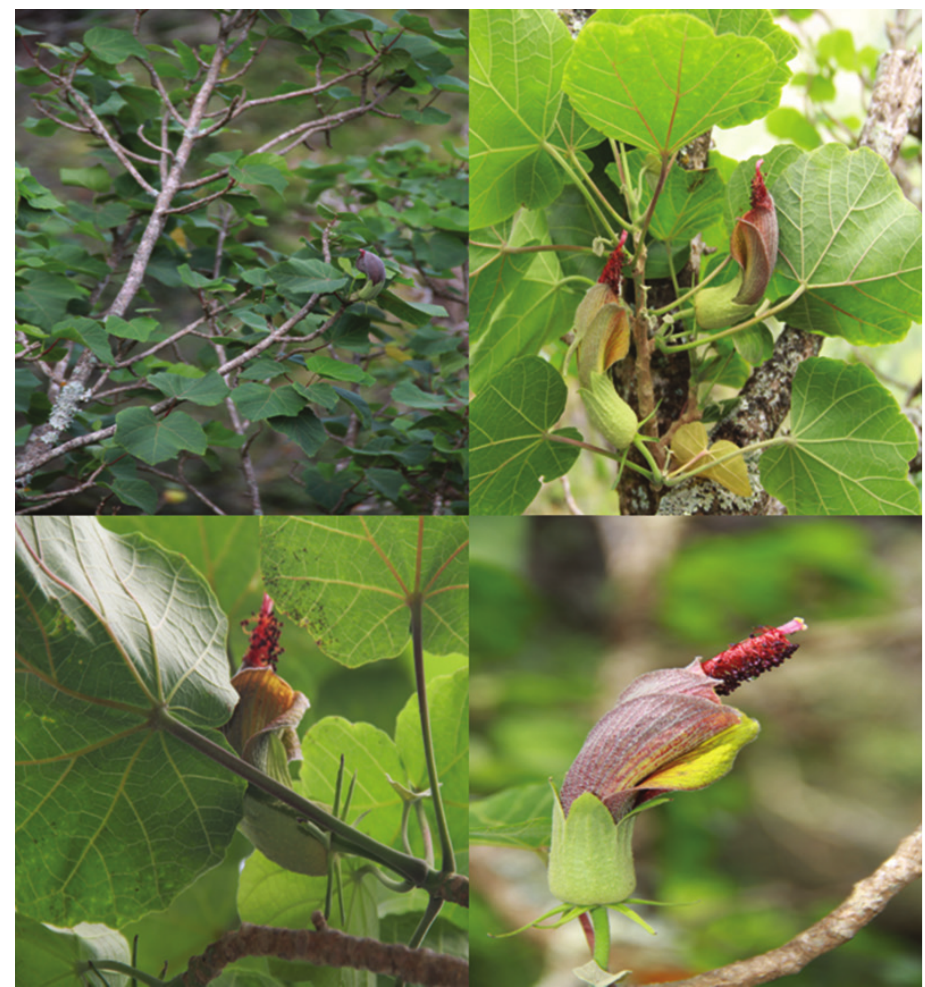
Figure 1. Hibiscadelphus stellatus. A Habit B Flowers and leaves (from the holotype) C View of bracts illustrating stellate arrangement D Close-up of flower. (from the holotype). All photos by the